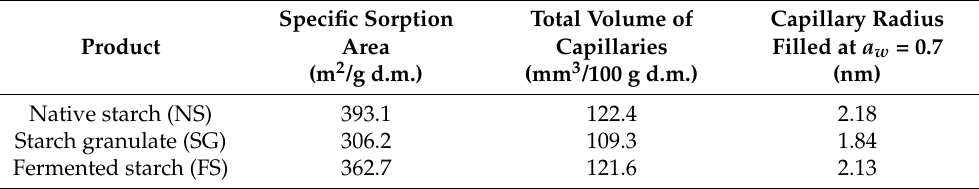
Table 5. Microstructural characteristics of the surface of the analyzed cassava